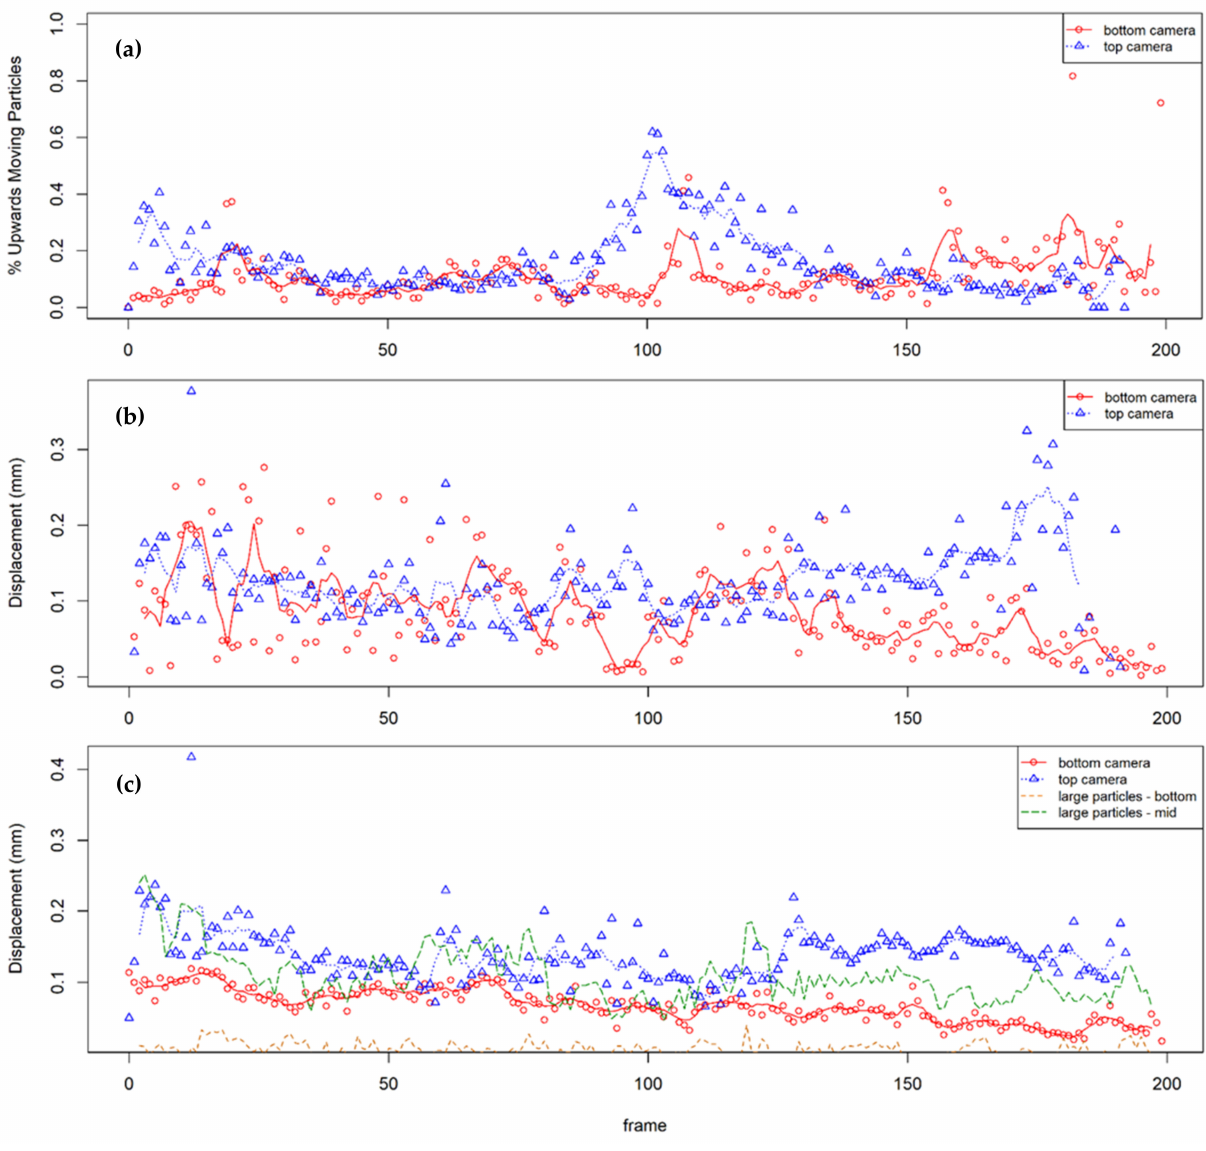
Figure 9. Analysis of average particle movement between successive photos: ( a ) % of upwards moving particles, ( b ) average upwards displacements, and ( c ) average downward